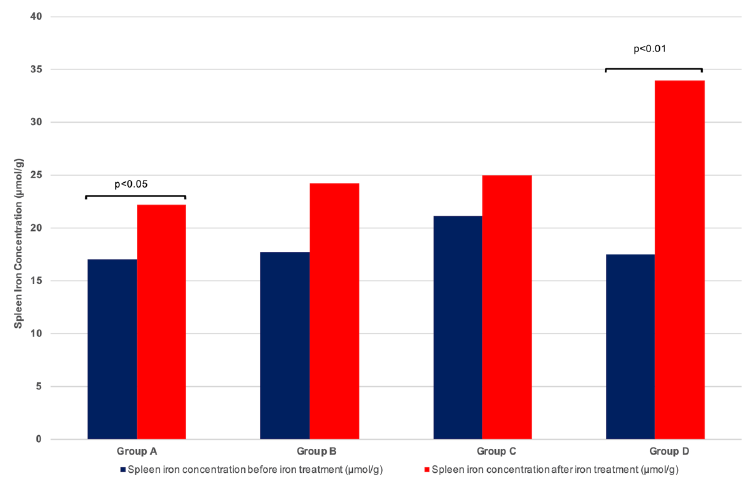
Figure 3. Evolution of spleen iron concentration (SIC) before and after iron therapy in 54 dialysis patients. Median SIC before and after treatment in: Group A: 11 patients treated with 1.2 g iron sucrose; Group B: 14 patients treated with 2.4 g iron sucrose; Group C: 15 patients treated with ferric carboxymaltose; Group D: 14 patients treated with iron isomaltoside. p value with Wilcoxon test. 3.4. Quantification of Iron Sequestered in the Liver and Spleen after IV Iron Infusions